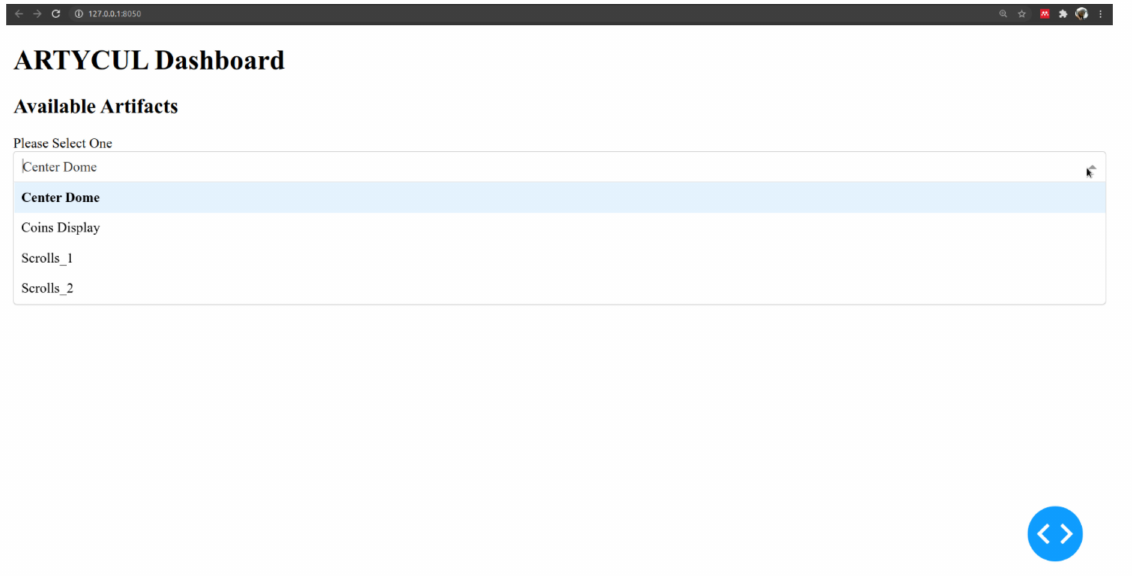
Figure 12. A prototype of the popularity dashboard module of ARTYCUL.